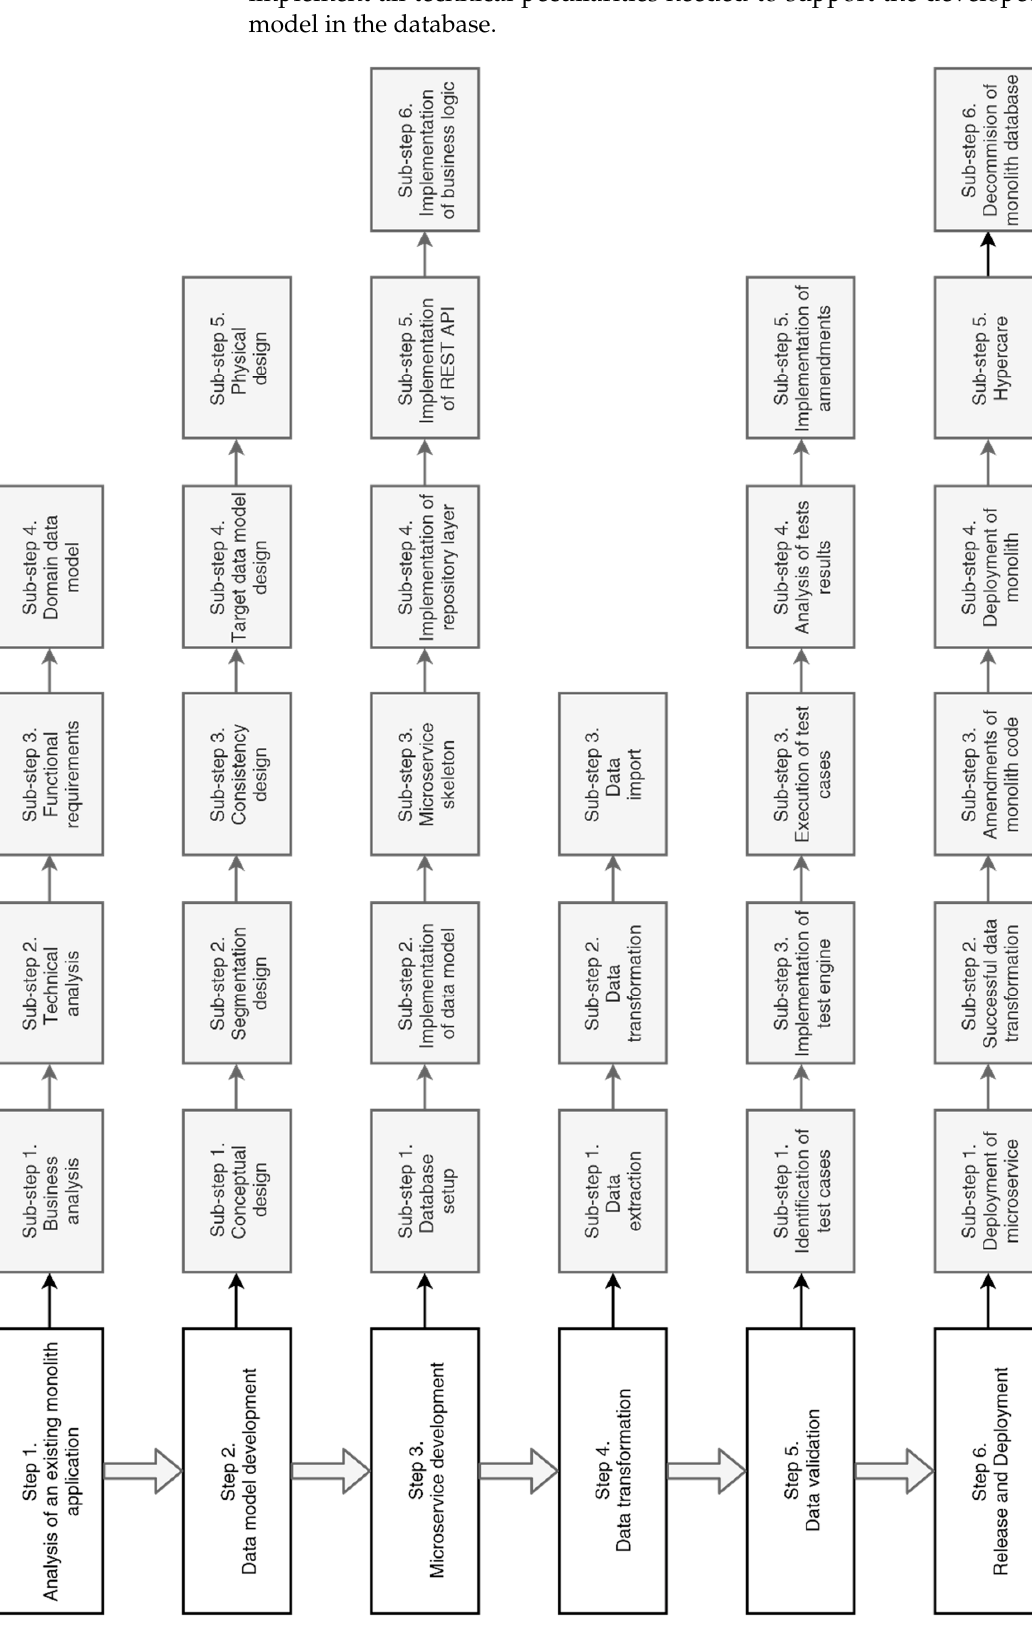
Figure 2. The proposed migration approach.